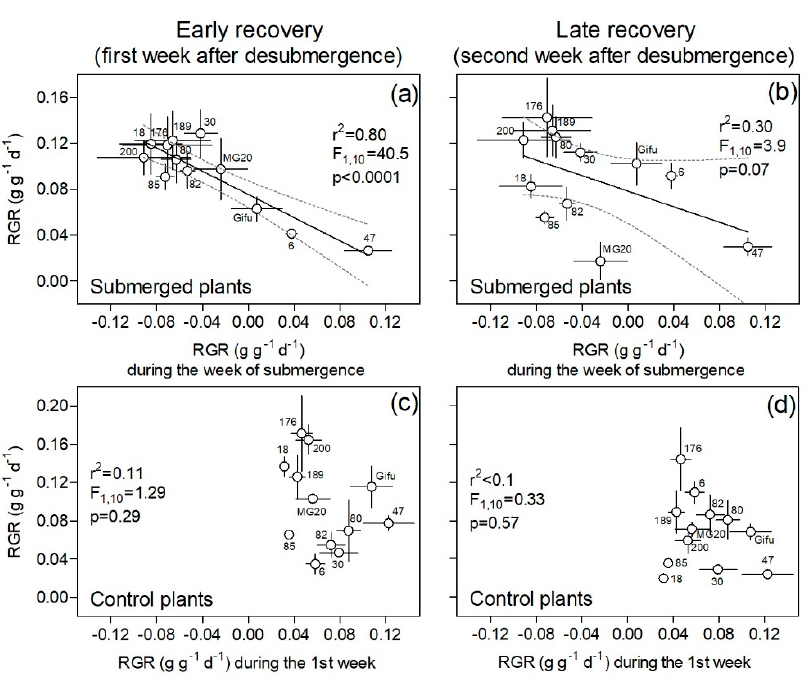
Figure 2. Plant relative growth rate (RGR) during ‘early’ and ‘late’ recovery vs. RGR during the first experimental week for one-week submergence ( a , b ) and control ( c , d ) treatments of 12 genotypes of Lotus japonicus (10 recombinant inbred lines and their parents Gifu and MG20). The first week after de-submergence was used to explore the relationship between these variables in an ‘early recovery’ phase ( a , c ) and the second week in a ‘late recovery’ phase ( b , d ). Values are means ± standard errors of 6–8 replicates.